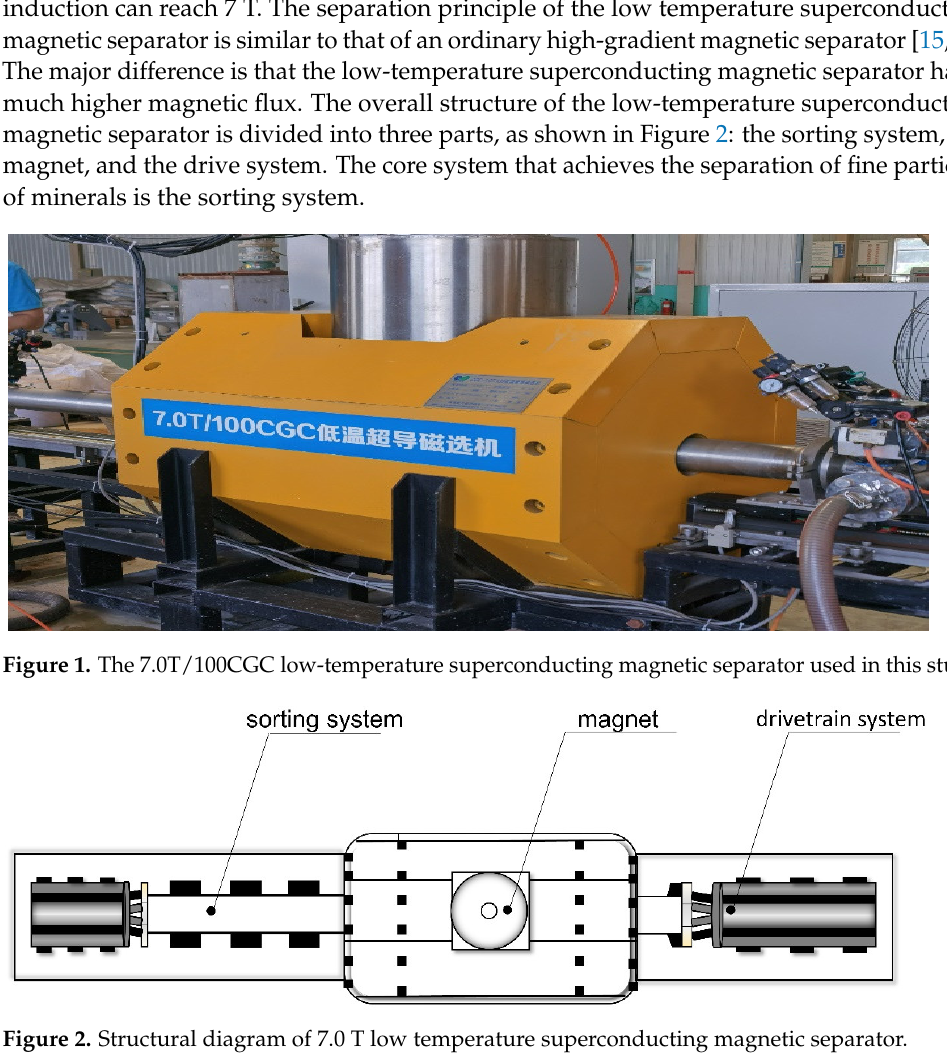
Figure 2. Structural diagram of 7.0 T low temperature superconducting magnetic separator.